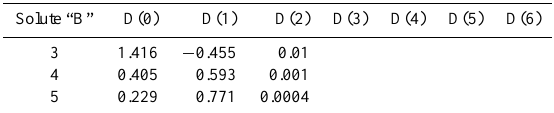
+ D ( 1 ) ∗ ) x ) =D ( 0 ) ∗ x 0 B w B order